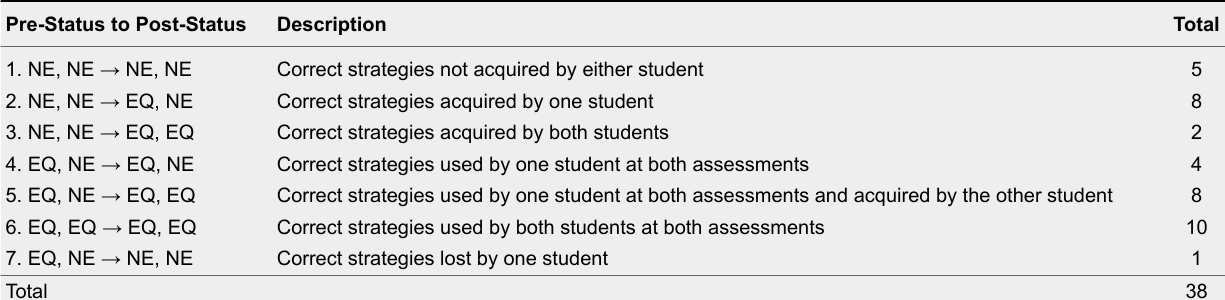
Seven Categories of Pair Relationships, According to Whether or not Students Acquired and Used Correct Strategies Between Pre- and